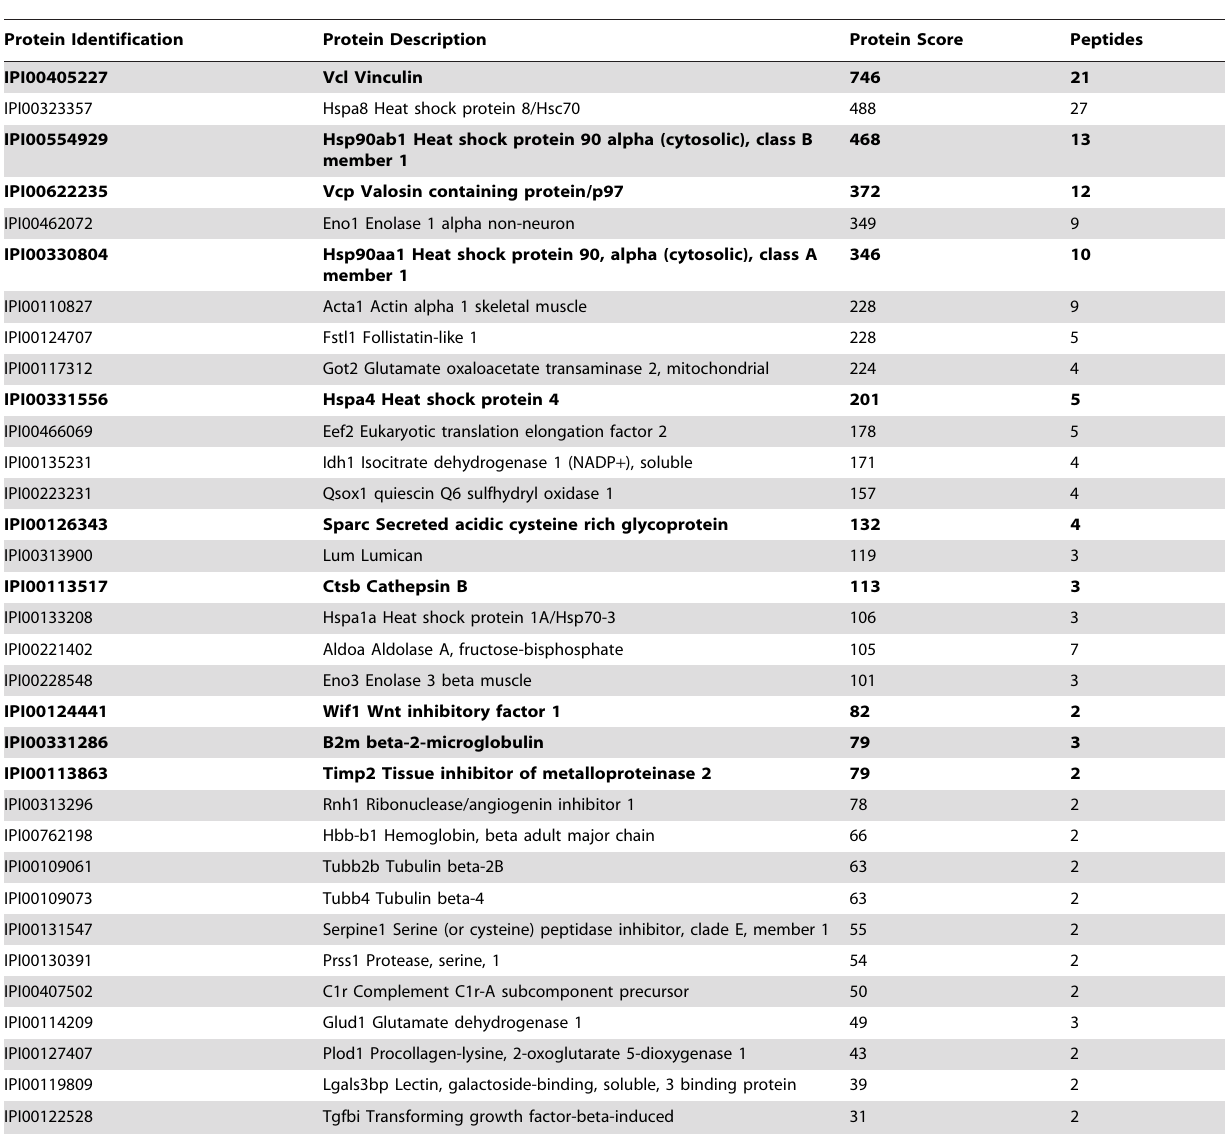
Table 1. Mass spectrometry analysis of the secretome of mouse GCT from CPA transgenic mice.